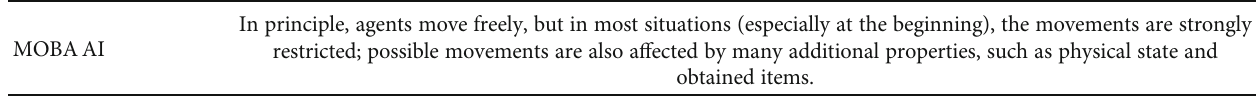
Table 5: Movements/state space property. How free is the AI in controlling movement? What additional data is needed to make up the state space? Team sportsAI